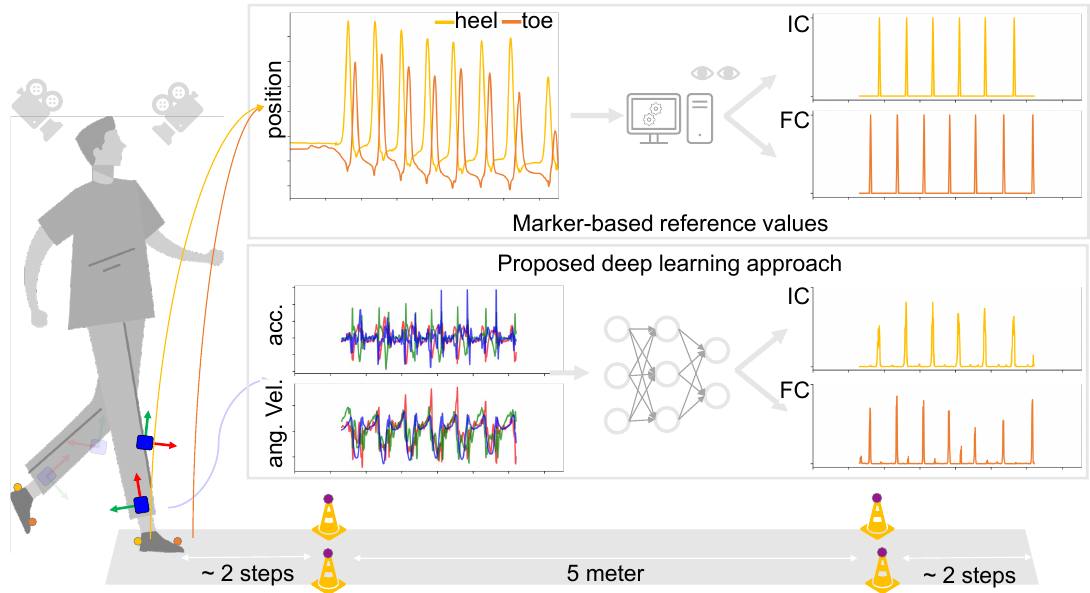
Figure 1. Schematic depiction (Picture from: https://www.vecteezy.com/free-vector/man-walking, accessed on 11 November 2021) of the current study. Study participants wore IMUs on the ankle and shanks, and reflective markers were adhered on the heel and toe of usual footwear (illustrated on the left ). Marker data were used to obtain reference values for the timings of initial and final contacts ( top ), where accelerometer and gyroscope data from each tracked point were inputted to a neural network that predicted timings of the same initial and final contacts ( bottom